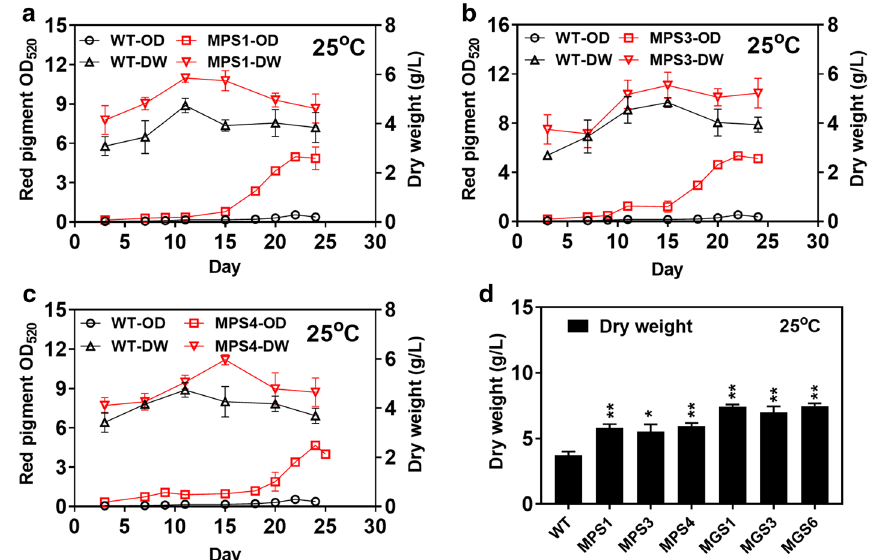
Fig. 3 Red pigment production and cell growth of mutants obtained by single transposable systems at 25 °C. The red pigment production of MPS1 ( a ), MPS3 ( b ) and MPS4 ( c ) were shown. d The dry weight from mutants of MPS1, MPS3, MPS4, MGS1, MGS3, MGS6. The value of the bar represents the highest pigment level or the highest biomass dry weigh at culture duration. WT, wild-type; DW, biomass dry weight. Determination of absorbance value of red pigment at wavelength of 520 nm (OD 520 ). Data of significance were shown in ** P < 0.01 and * P <